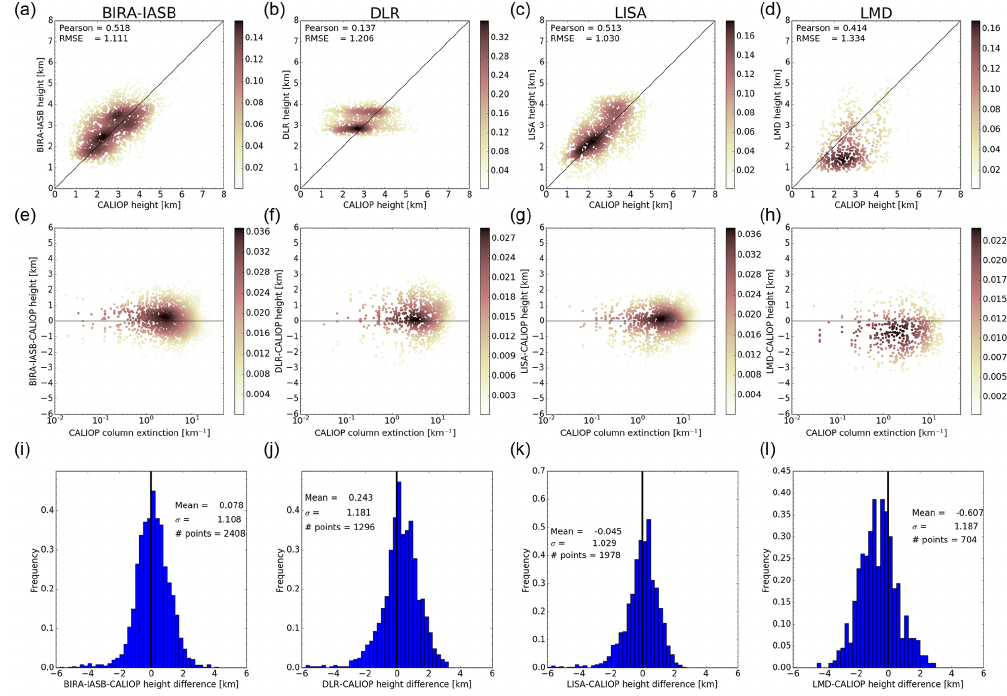
Figure 6. Similar to Fig. 5 but for the CALIOP geometric mean